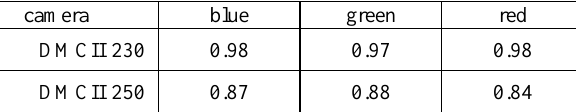
Tab. 3 : factor for effective resolution